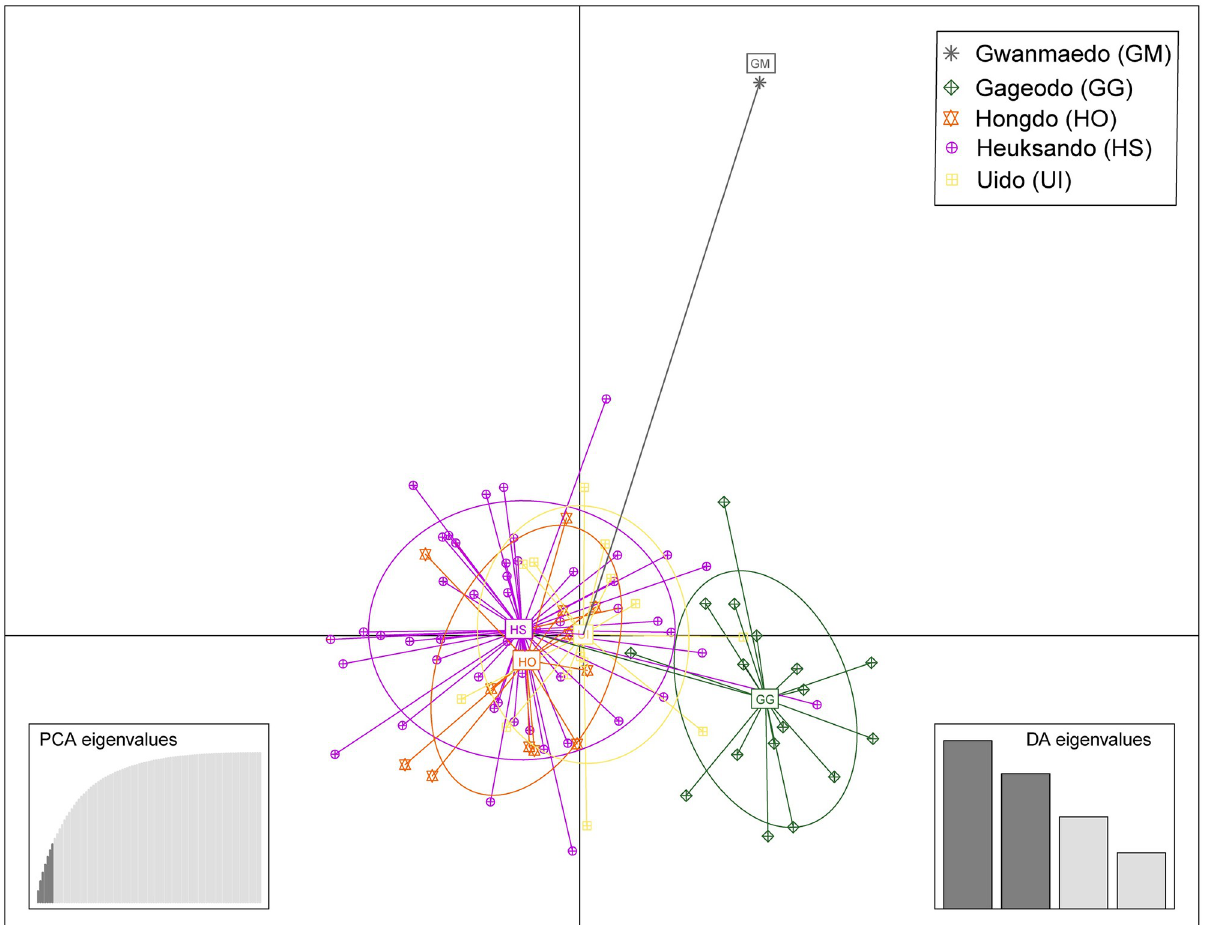
Fig 3. Scatterplot output from DAPC for the genetic structure of Saussurea polylepis individuals. Dots represent individuals from the 5 populations, and each color and symbol represent different populations.